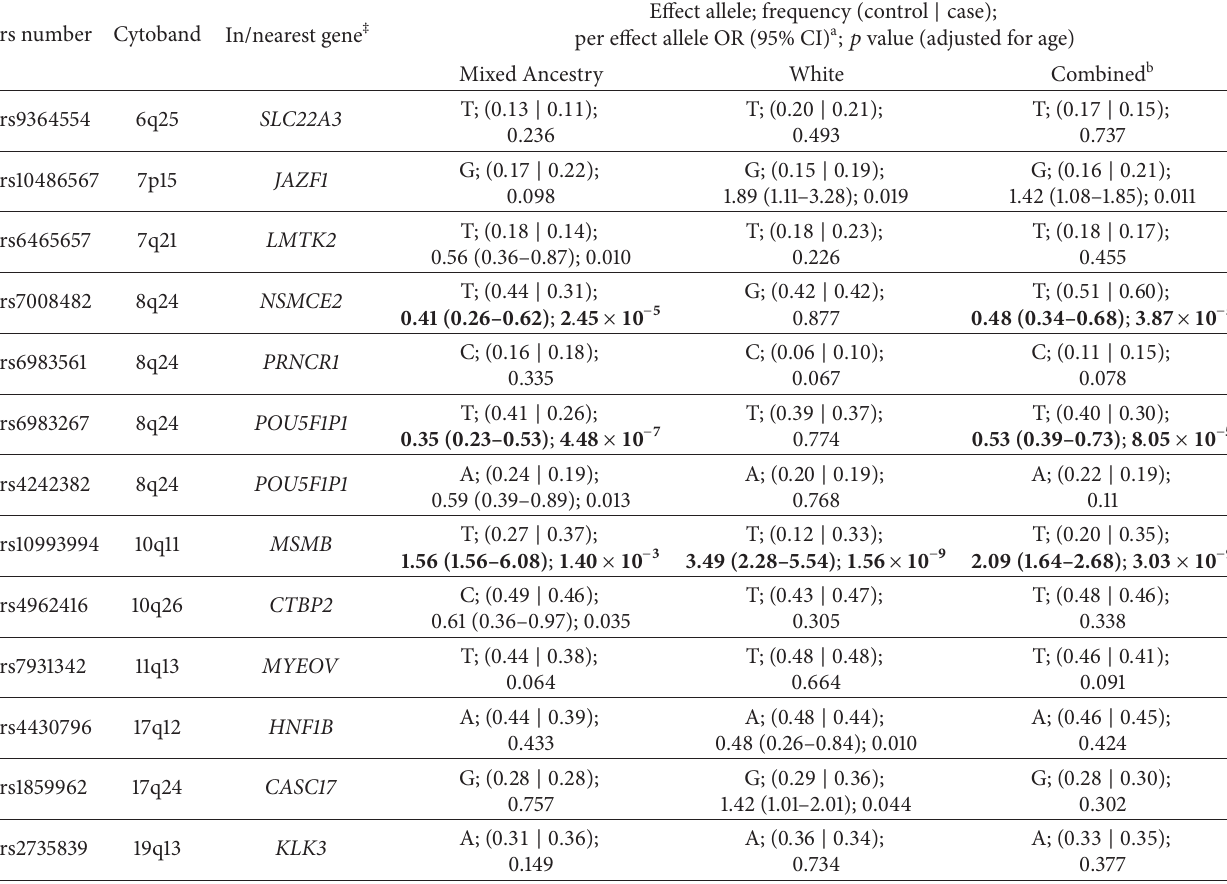
Table 2: Summary results for SNP genotyping analysis in South African men. Effect allele; frequency (control | rs number Cytoband In/nearest gene ‡